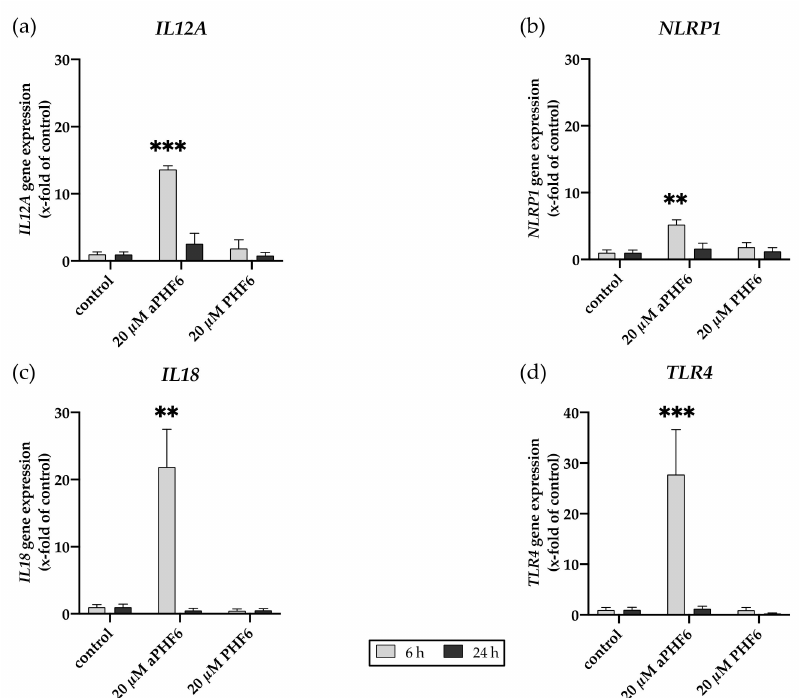
Figure A4. Aggregated PHF6 induced gene expression of M1 markers. ( a ) IL12A , ( b ) NLRP1 , ( c ) IL18 , and ( d ) TLR4 gene expression after 6 and 24 h of aPHF6 treatment. ** p < 0.01; *** p <